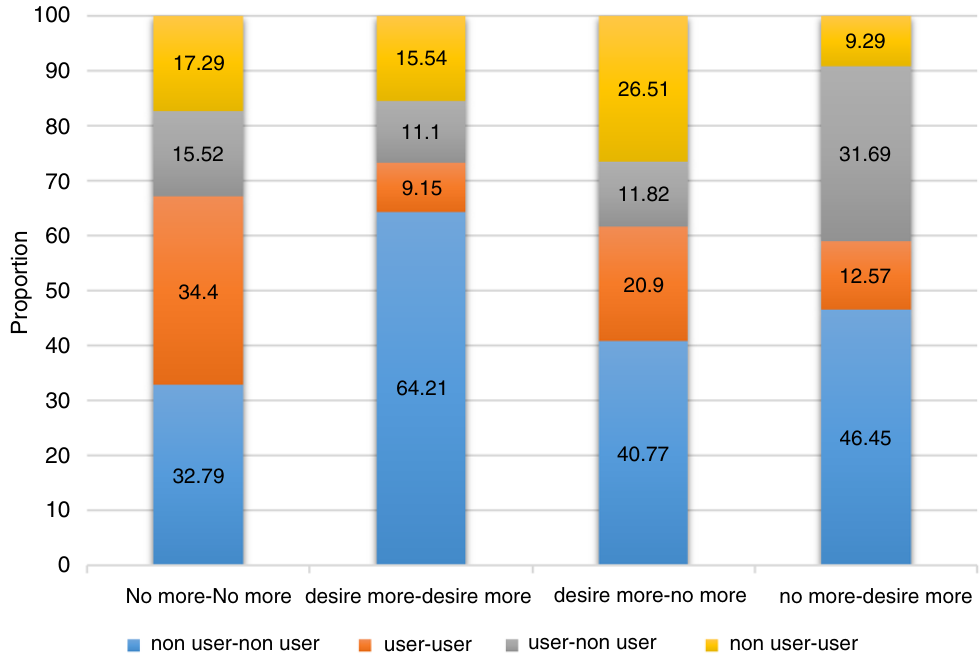
Figure 1. Changing status of modern contraceptive use over time according to change in fertility desires.